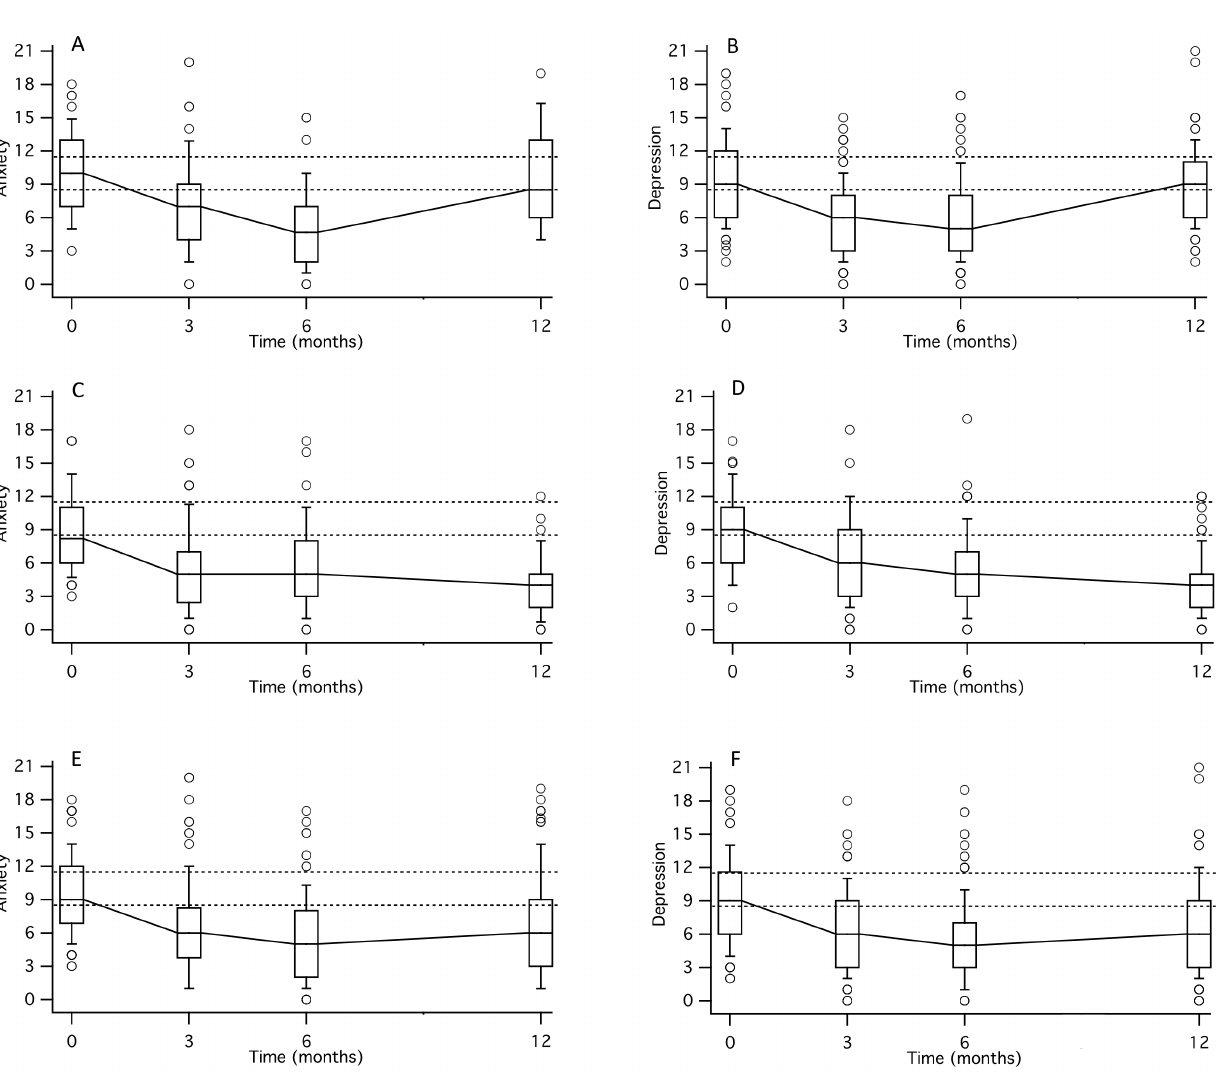
Figure 2. Box-and-whisker plots showing scores on the anxiety and depression scales at the four measurement times. The line inside each box indicates the median, the bottom and top indicate the 25th and 75th percentiles, and the ends of the whiskers indicate the 10th and 90th percentiles. Lines connecting the medians were drawn to show patterns of change over time. Higher scores indicate more symptoms and more frequent symptoms. The horizontal dotted lines show the criteria used to define non-cases (scores # 8), possible cases (scores of 9, 10, and 11), and probable cases (scores $ 12) [34]. Panels (A) and (B) show the results from the participants who had substantial improvement that was followed by substantial decline. The decay-of-impact pattern is clearly visible: First the scores decreased (improvement) and later they increased (worsening). It is also clear that, as part of the decay of impact, many participants moved among the clinical categories. Specifically, many of them moved into a better clinical category within the first half of the follow-up year and by the time of the last measurement they had returned to a worse category. For (A), n=70, and for (B), n=90. Panels (C) and (D) show the results from the participants who had substantial improvement that was not followed by substantial decline. These participants did not have decay of impact. For (C), n=76, and for (D), n=99. Panel (E) shows the data from (A) and (C) combined (n=146), and panel (F) shows the data from (B) and (D) combined (n=189). When the data are combined the decay of impact is almost completely